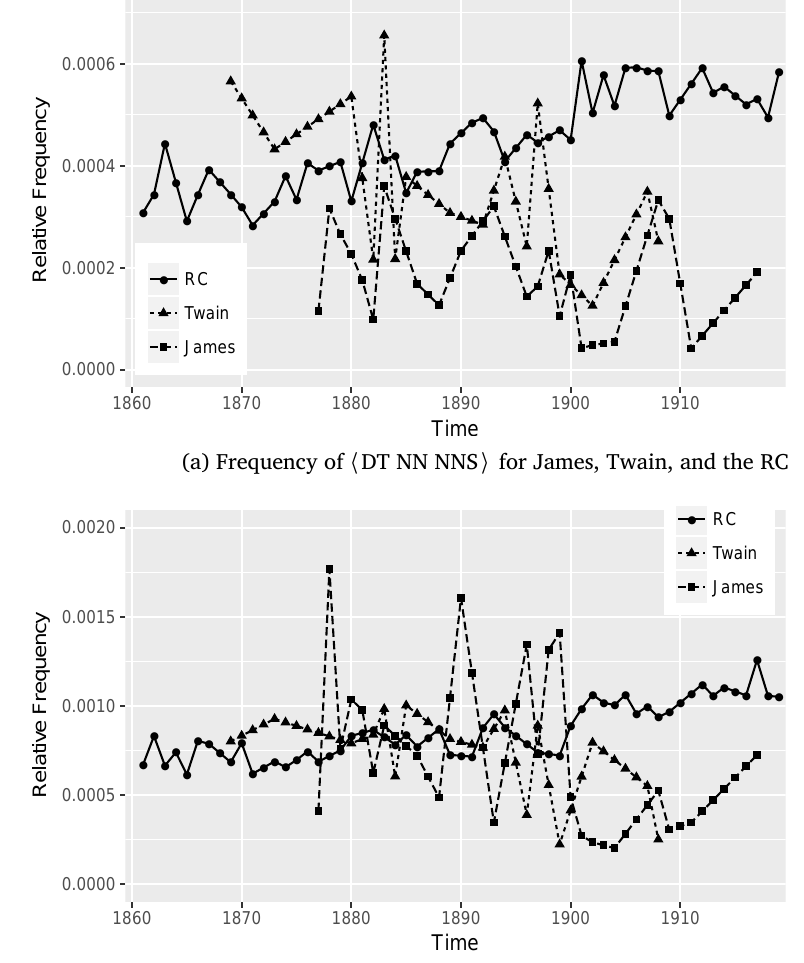
Figure 13: Decrease in two noun phrase types for the two-author data set and increase for the reference